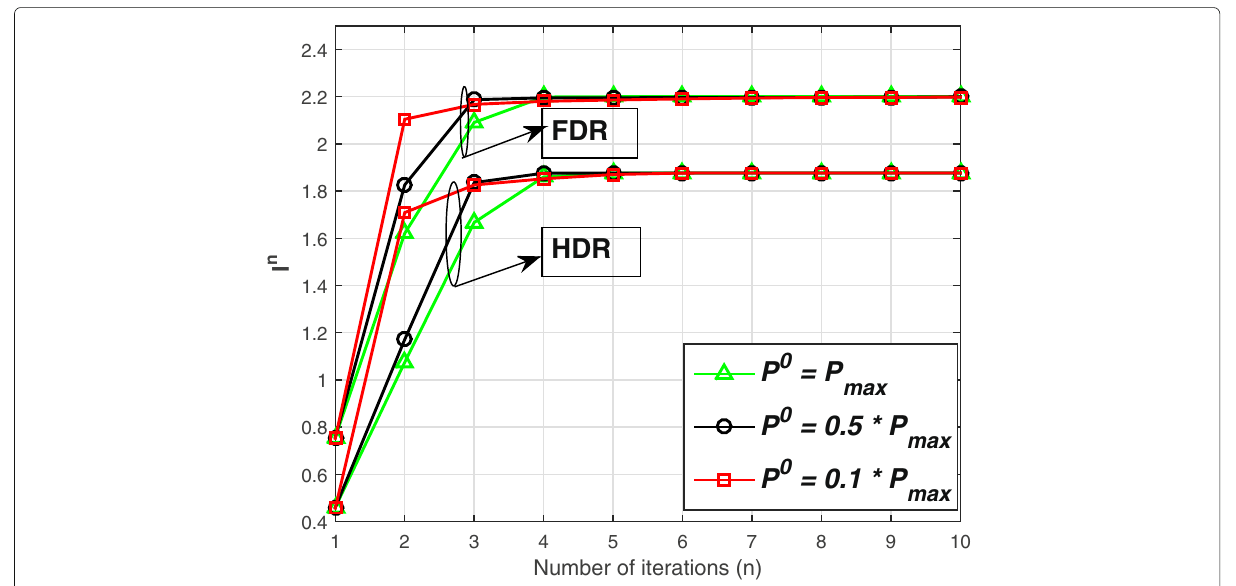
Fig. 6 Convergence of Algorithm 1 for FDR/HDR systems under I-CSI: P max = 40 dB, m = 1, π 0 = 0.01, and N = 3